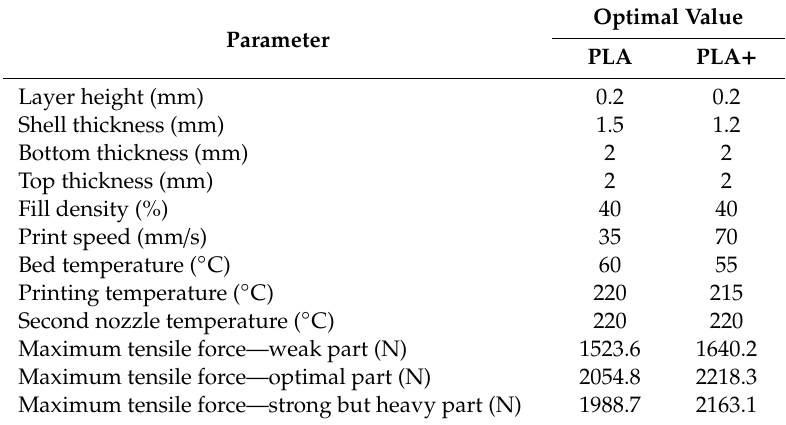
Table 3. Optimal parameters for 3D printing using PLA and PLA +